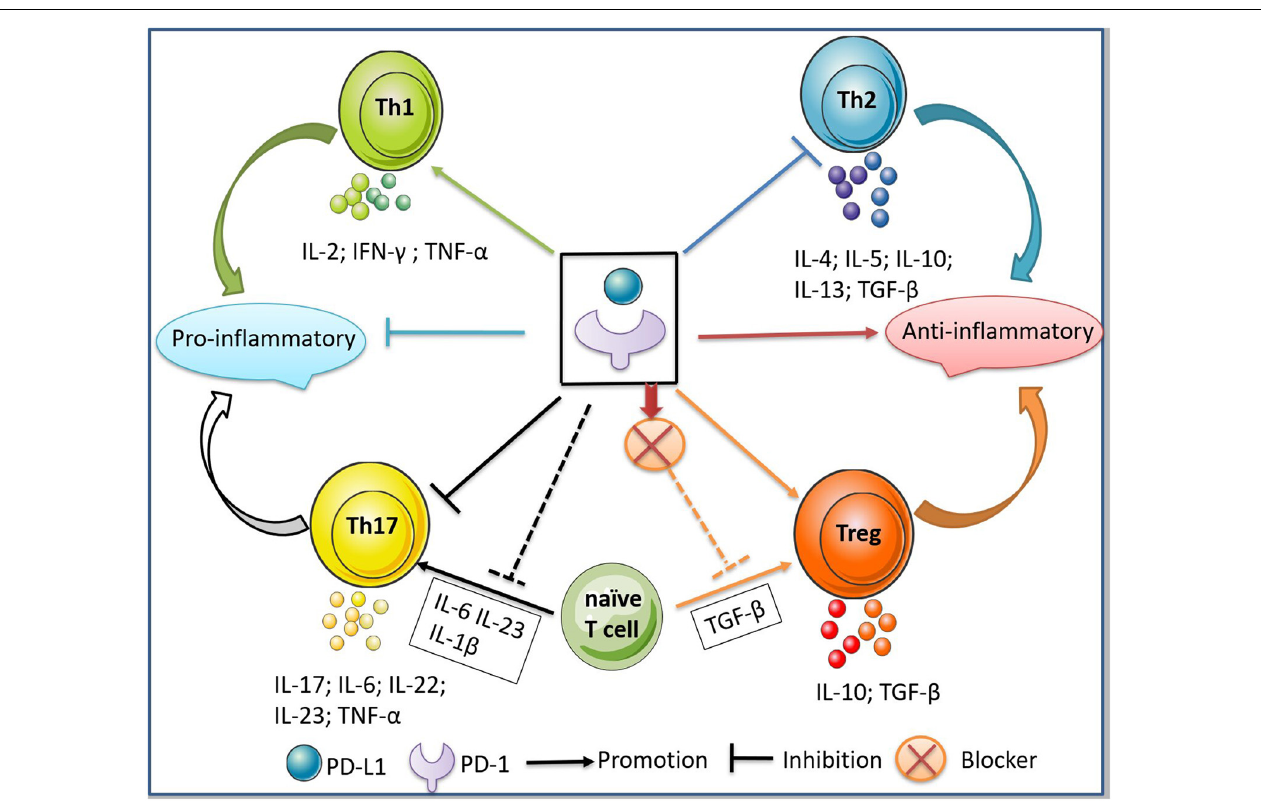
FIGURE 3 | Regulation of PD-1/PD-L1 between Th1/Th2 and Th17/Treg cells. The binding of PD-1/PD-L1 inhibits the differentiation of Th1/Th17 cells and the secretion of pro-inflammatory cytokines, thus further inhibiting the inflammatory responses. Meanwhile, the binding of PD-1/PD-L1 promotes the differentiation of Th2/Treg cells and the secretion of anti-inflammatory cytokines, thus exerting an immunosuppressive effect. In addition, the addition of PD-L1 to the microenvironment where naive T cells differentiate into Th17 cells inhibits the production of Th17, while the blockade of PD-1 to the microenvironment where naive T cells differentiate into Treg inhibits the production of Treg